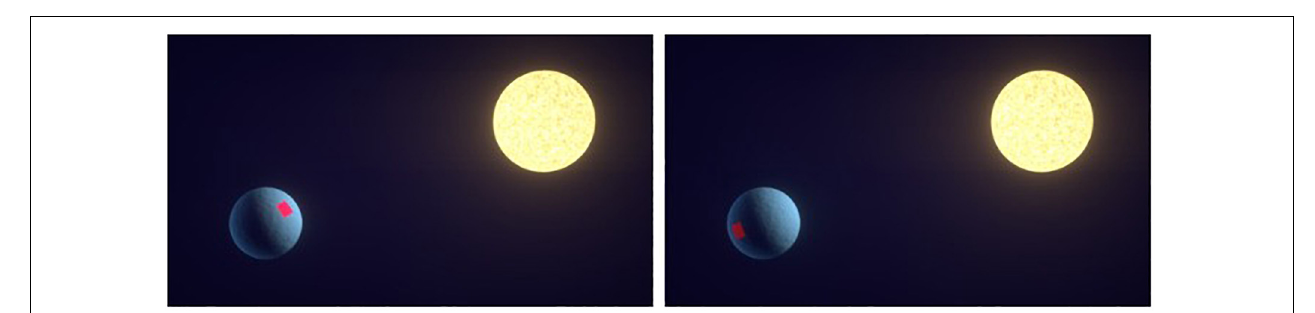
FIGURE 1 | (A–F) Types of inscriptions.